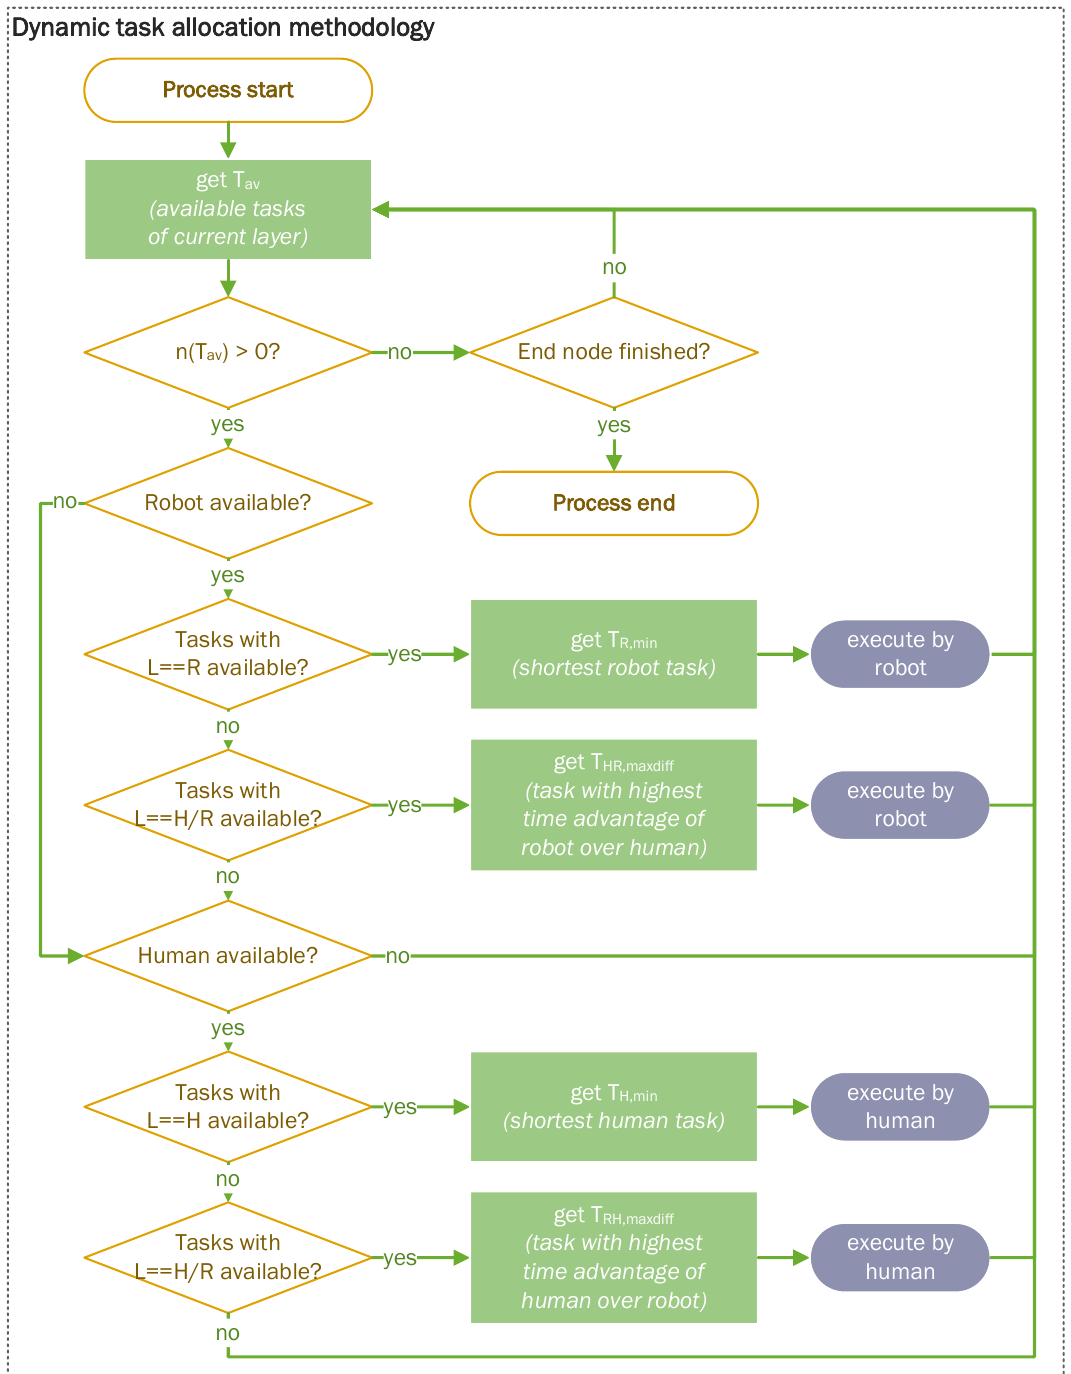
Figure 7. Flowchart of the proposed methodology for dynamic task allocation (simplified version). The iteration is continuous, i.e., after an assignment, the decision logic is immediately repeated by requesting currently available tasks again without waiting for the completion of the last assigned